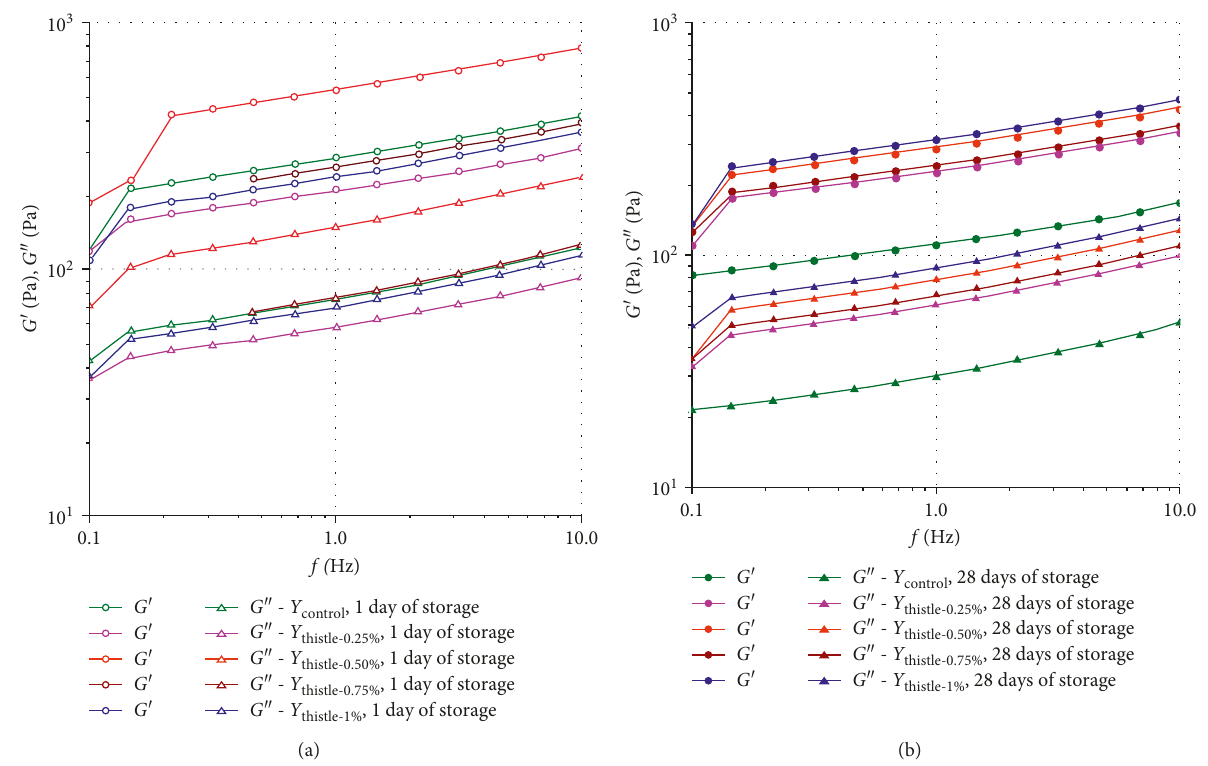
Figure 5: Viscoelastic properties of yogurt with thistle ( Silybum marianum L.) extract: (a) 1 day of storage; (b) after 28 days of